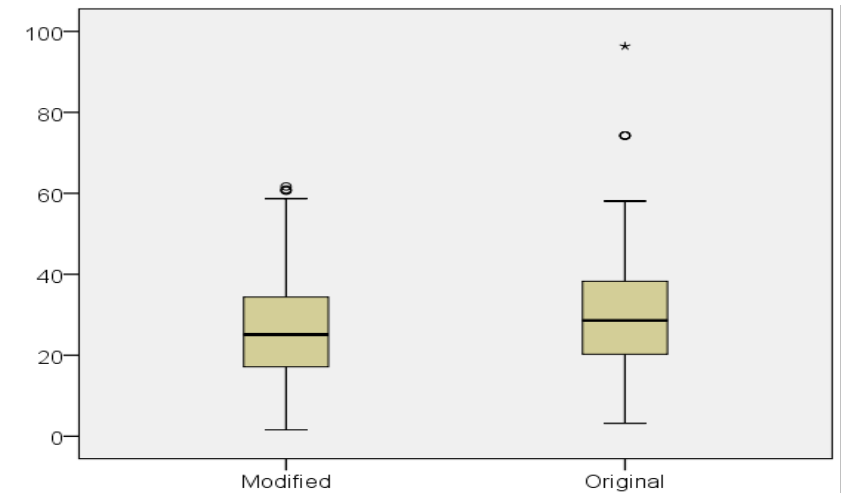
Figure 2 Box Plot showing the changes in FRES due to modifications (n=281)